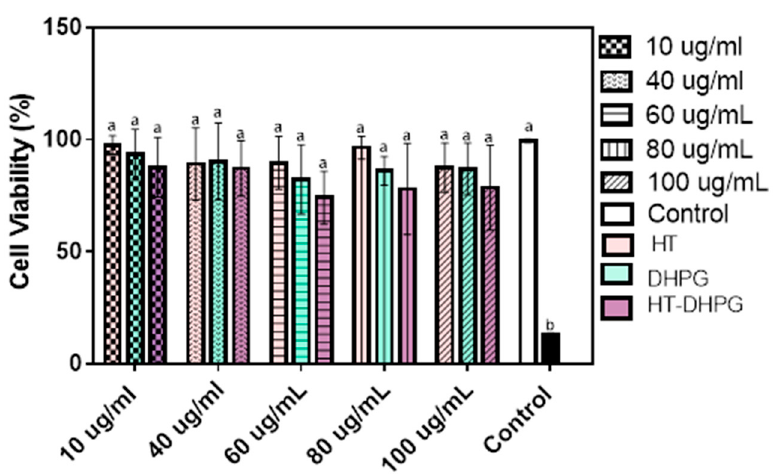
Figure 5. Cell viability (%) determined by 3-(4,5-dimethylthiazol-2-yl)-2,5-diphenyltetrazole bromide (MTT) assay, in the presence of three different extracts HT, DHPG, and HT–DHPG, after 3 h of treatment and different concentrations (10, 40, 60, 80, and 100 µg/mL). Values marked with different letter are significantly different ( p < 0.05).